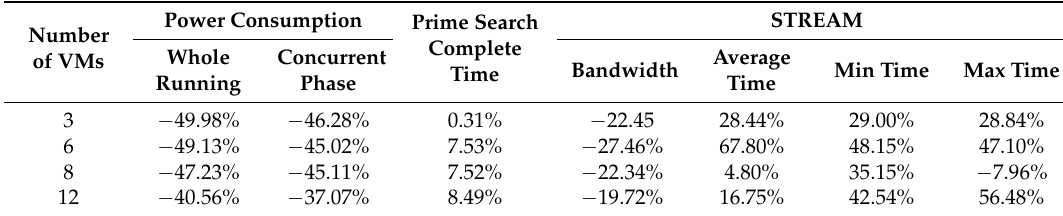
Table 8. Power consumption and performance comparison of different scheduling